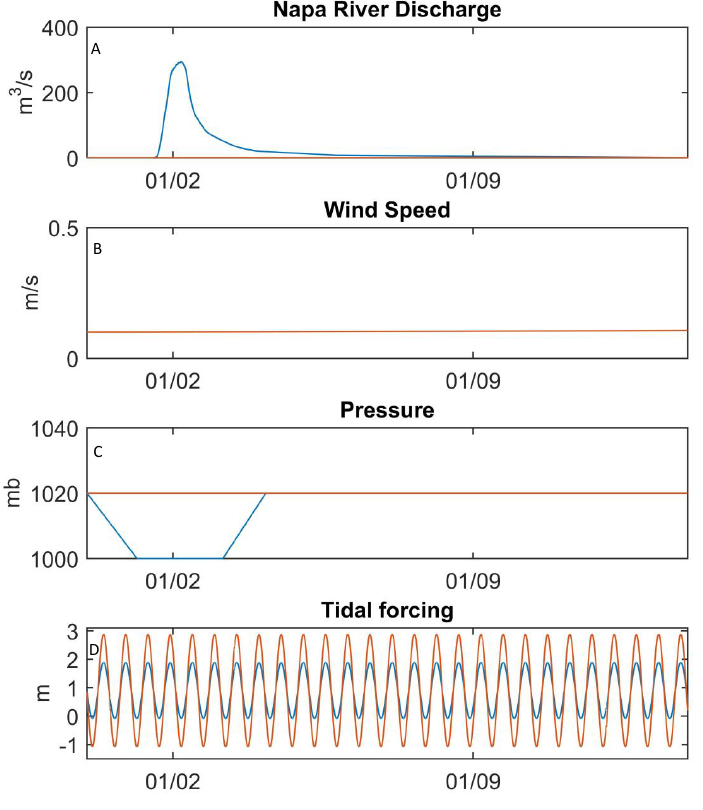
Figure 4. Idealized storm forcings ( A ) Discharge at head of Napa River. ( B ) Wind speed (spatially uniform over entire domain). ( C ) Atmospheric pressure (red is non-storm and blue is storm condition). ( D ) Tidal water level forced at southern bay boundary (red is 2-m M 2 tide and blue is 1-m M 2 tide). Table 3. Idealized model runs and their forcings.